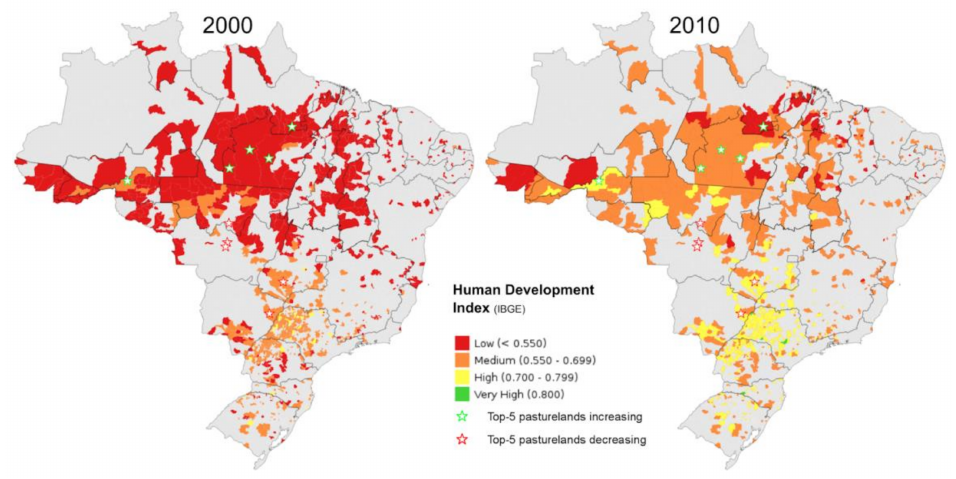
Figure 10. 2000 and 2001 Human Development Index (HDI) values of the municipalities located in the expansion and retraction zones of the Brazilian livestock